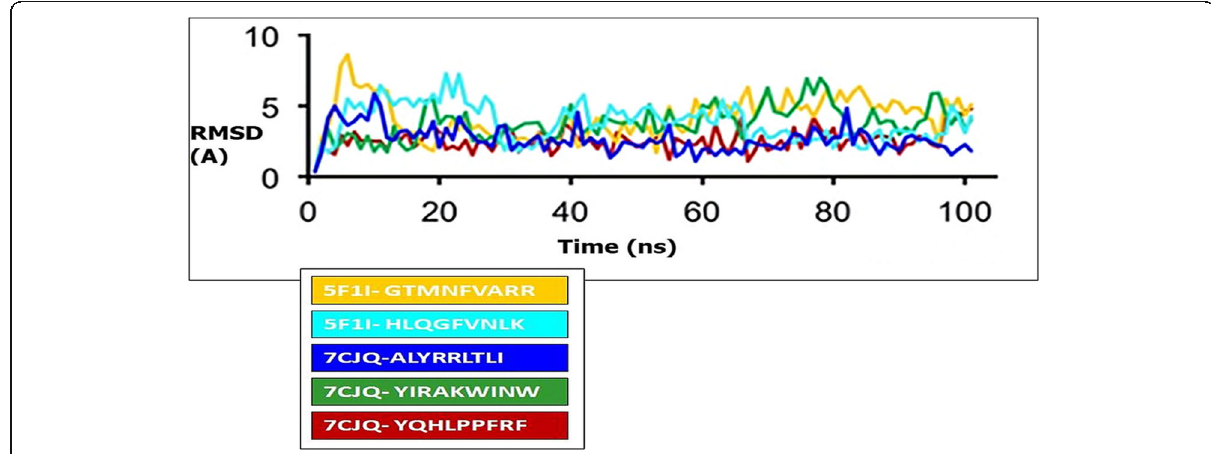
Fig. 2 RMSD plot for 5 selected epitopes-DLA